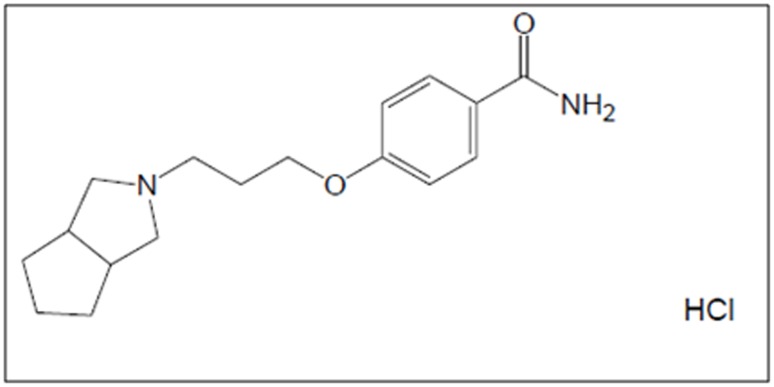
Chemical formula of S 38093 (C17H24N2O2, HCl).